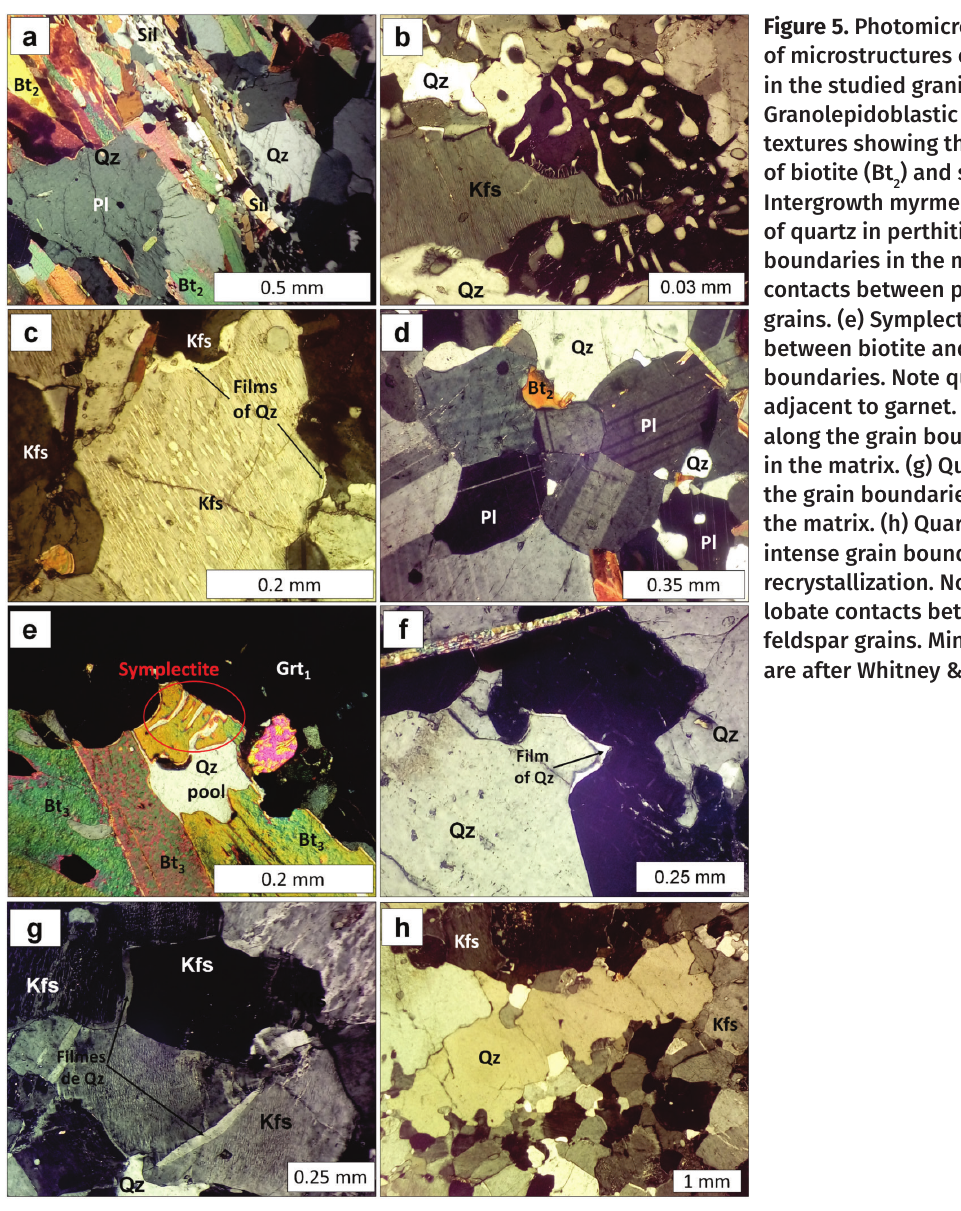
Figure 5. Photomicrographs of microstructures observed in the studied granites. (a) Granolepidoblastic and nematoblastic textures showing the orientation ) and sillimanite. (b) of biotite (Bt 2 Intergrowth myrmekite. (c) Films of quartz in perthitic K-feldspar boundaries in the matrix. (d) Polygonal contacts between plagioclase (Pl) grains. (e) Symplectite intergrowth between biotite and quartz in garnet boundaries. Note quartz-filled pools adjacent to garnet. (f) Quartz films along the grain boundaries of garnet in the matrix. (g) Quartz films along the grain boundaries of K-feldspar in the matrix. (h) Quartz ribbon shows intense grain boundary migration recrystallization. Note ameboid to lobate contacts between quartz and feldspar grains. Mineral abbreviations are after Whitney & Evans